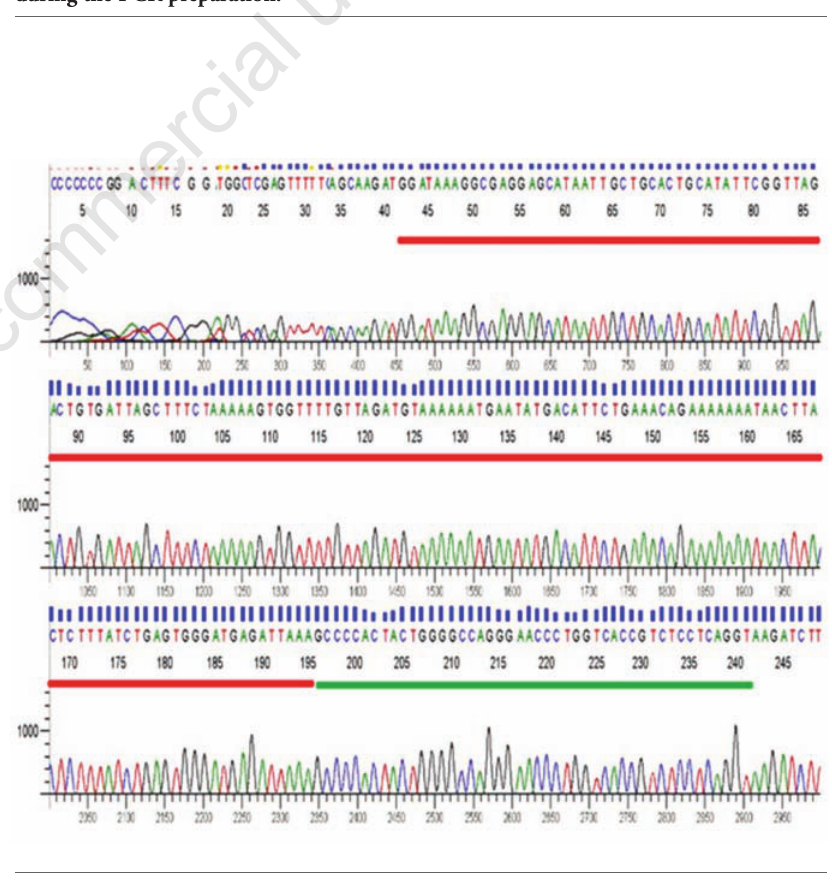
Figure 2. Chromatogram of RM9 in forward direction. Sequencing results showed that RM9 contained the joining sequences of G1/S-specific cyclin-D1 (red line) and IGHJ4 (green line) located at chromosome 11 and 14, respectively. The remaining sequences were the vector